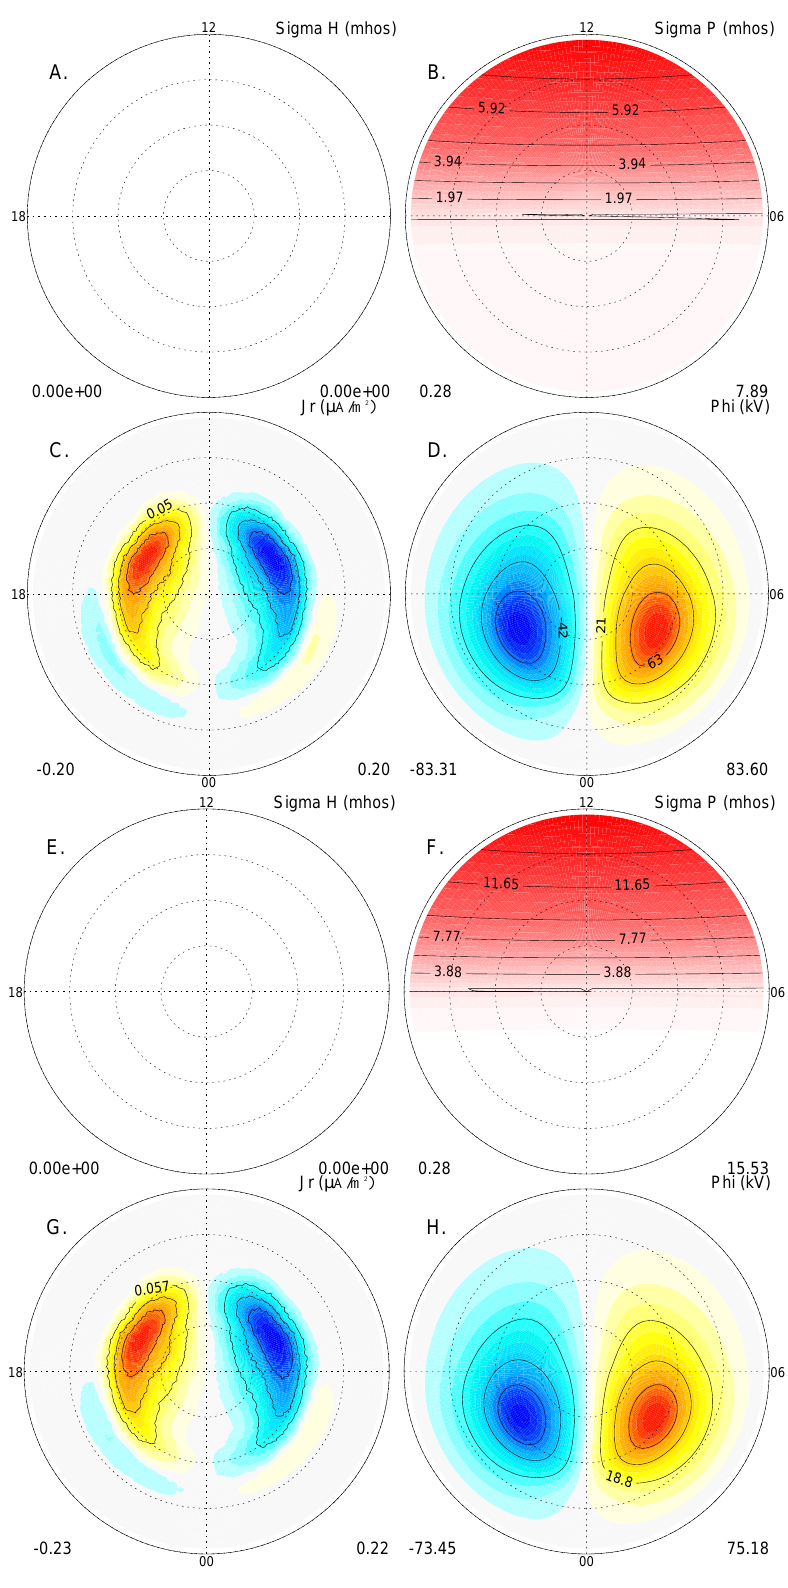
Plate 4. The top cluster of 4 plots (A–D) are the ionospheric results from a simulation during solar minimum, while the bottom 4 plots (E–H) are from solar maximum. The runs were conducted with the Hall conductance equal to 0. The plots are (A, E) the Hall conductance; (B, F) Pedersen conductance; (C, G) field-aligned currents; and (D, H) potential pattern. Each plot is in the same coordinate system as Plate